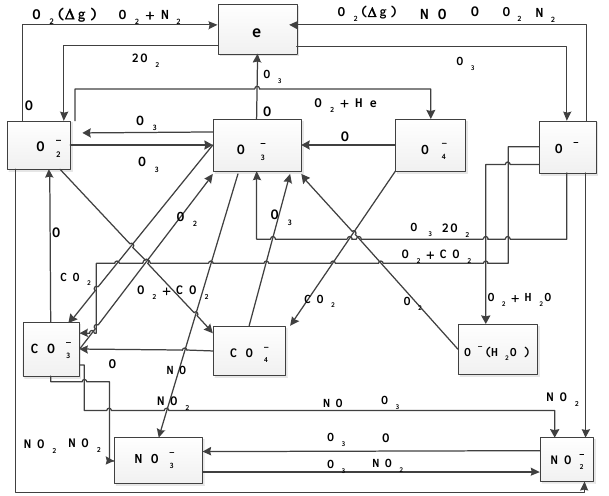
Figure 1. Main positive ion reaction scheme.